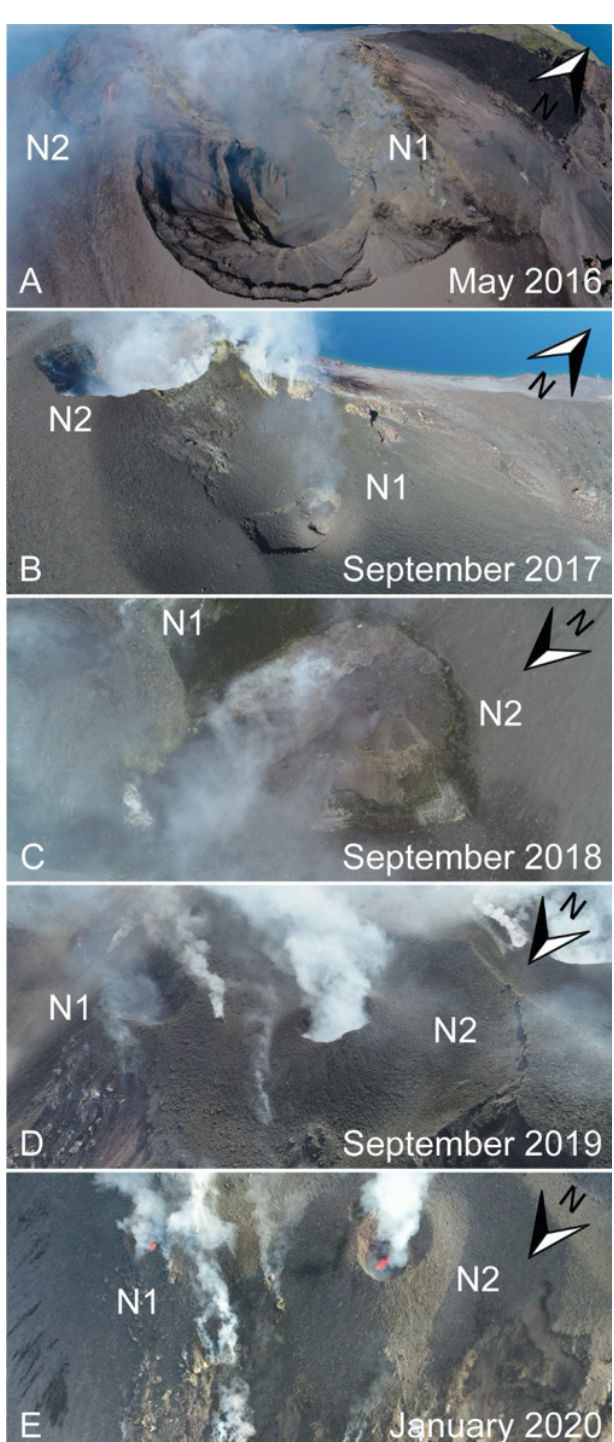
Figure 2: Strong morphological variations of N1 and N2 (vents 1 and 2 of the N vent area) of Stromboli volcano, Italy, due to recurring subsidence/collapse events and accumulation of pyroclastic material as seen by UAVs between 2016 and 2020. Arrows indicate